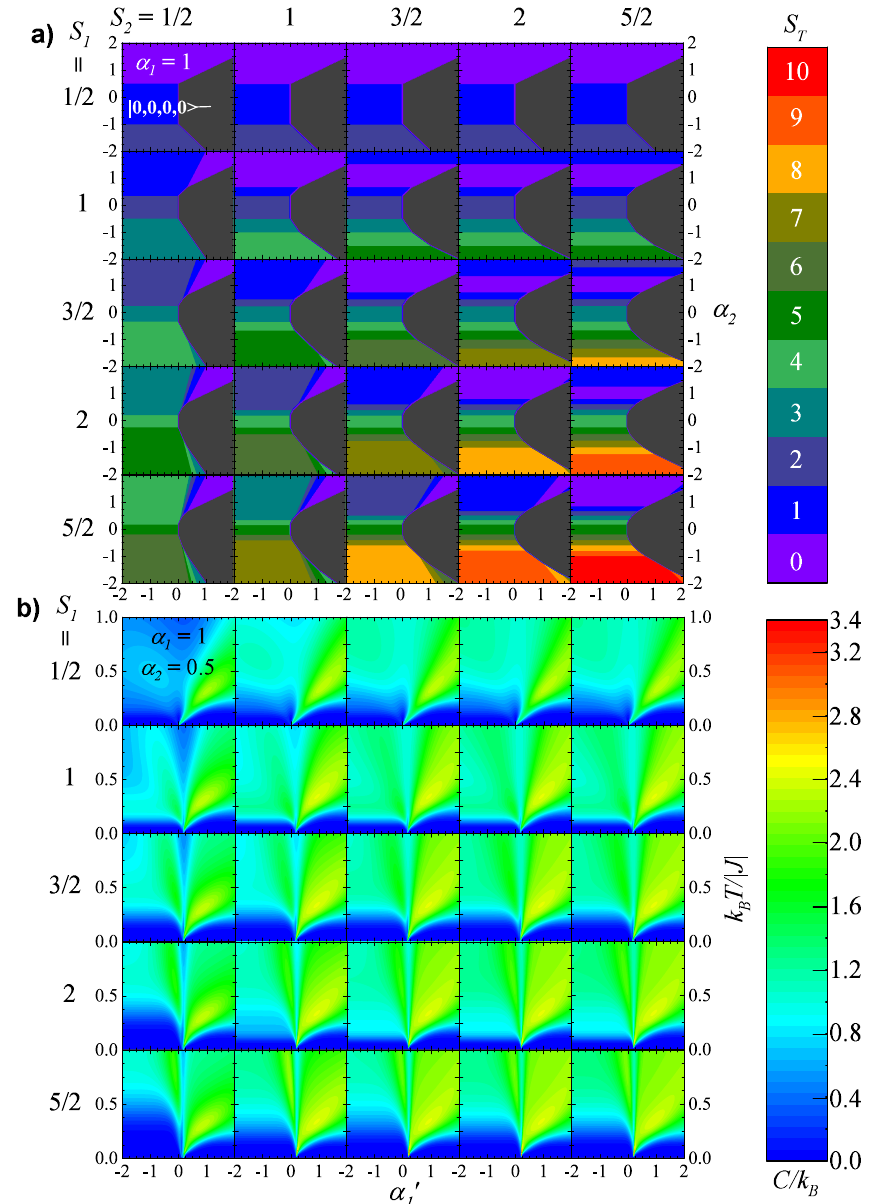
Figure 4. The ground state energy levels and heat capacities as functions of α i and temperature in the case of zero-field and J = 1. S 1 and S 2 denote the spins of the atoms making up S d 1 and S d 2 , respectively. The scale bar at the top right of the figure is for the total spin of the system, S T , and relates a particular value to a color in the ground-state energy diagrams. Energy increases from a low value of S T to a higher value. The scale at the bottom right of the figure denotes the value of heat capacity (in arbitrary units). ( a ) The ground-state energy map as a function of α (cid:48) and α 2 with 1 the restriction of α 1 = 1; ( b ) The associated heat capacities for the ground-state energy map in a as a function of α (cid:48) and k B T / | J | with the restrictions of α 1 = 1 and α 2 = 0.5. The gray areas in a and c 1 denote the | 0,0,0,0 > state ( | S T , S d 1 , S d 2 , m z > ). Moving onto Figure 4: the diagram in Figure 4a is the ground-state energy map as a function of α (cid:48) and α 2 with the restriction of α 1 = 1. The diagram in Figure 4b is the 1 respective heat capacity as a function of α (cid:48) and k B T / | J | with the restrictions α 1 = 1 and 1 α 2 = 0.5. S 1 and S 2 denote the spin values of the constituent spins making up S d 1 and S d 2